Question: Briefly state, in one sentence, what is plotted here.
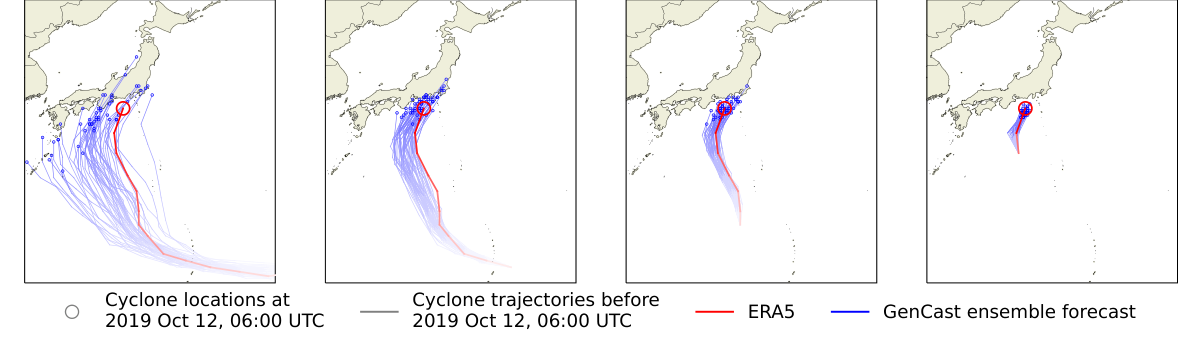
Answer: | Visualisation of forecasts and tropical cyclone tracks for the validity time of 12 October, 2019, 06 UTC, hours before Typhoon Hagibis made landfall in Japan. (a) The ERA5 analysis state for specific humidity at 700hPa, at validity time 06 UTC, October 12, 2019, shows Typhoon Hagibis near the center of the frame. (b-d) Three sample GenCast forecast states, initialised one day earlier, show how the samples are sharp, and very similar to one another. (e) The GenCast ensemble mean, obtained by computing the mean of 50 sample states like in (b-d), is somewhat blurry, showing how uncertainty results in a blurrier average state. (f) The forecast state from (deterministic) GraphCast, initialised one day earlier like in (b-e), is blurry, similar to GenCast’s ensemble mean. (g) The spatial power spectrum of the states in (a), (b), (e), and (f), where line colors match the frames of the panels, show how GenCast samples’ spectra closely match ERA5’s, while the blurrier GenCast ensemble